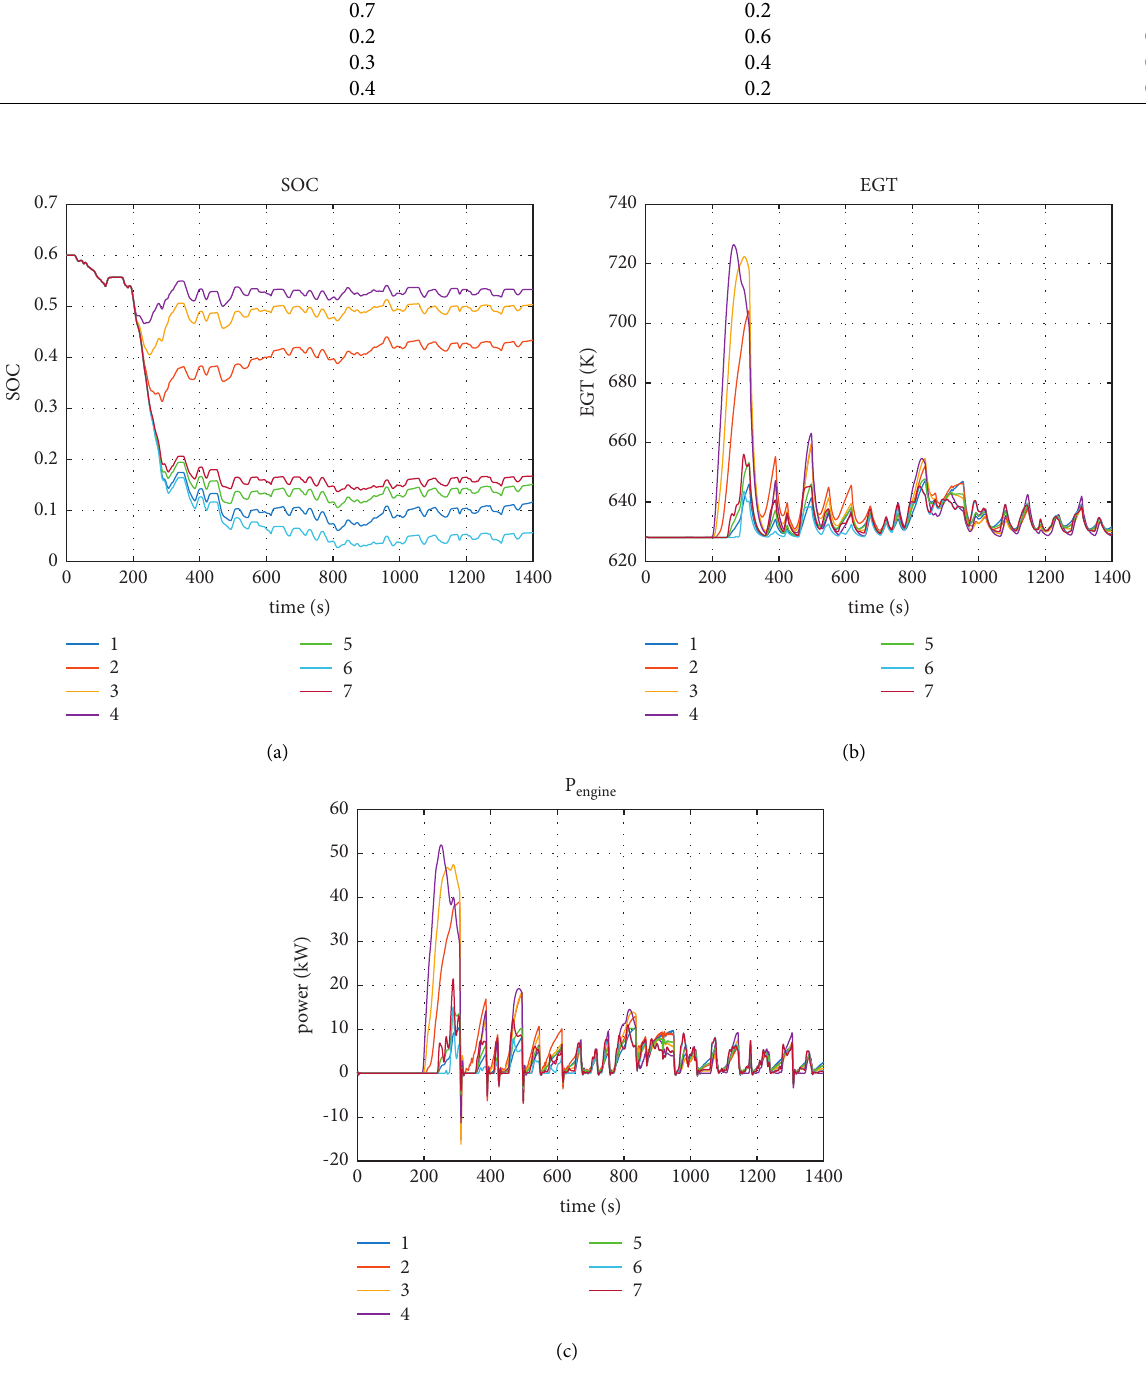
Figure 18: Simulation results comparison. (a) SOC of power battery. (b) EGTof turboshaft engine. (c) Output power of turboshaft